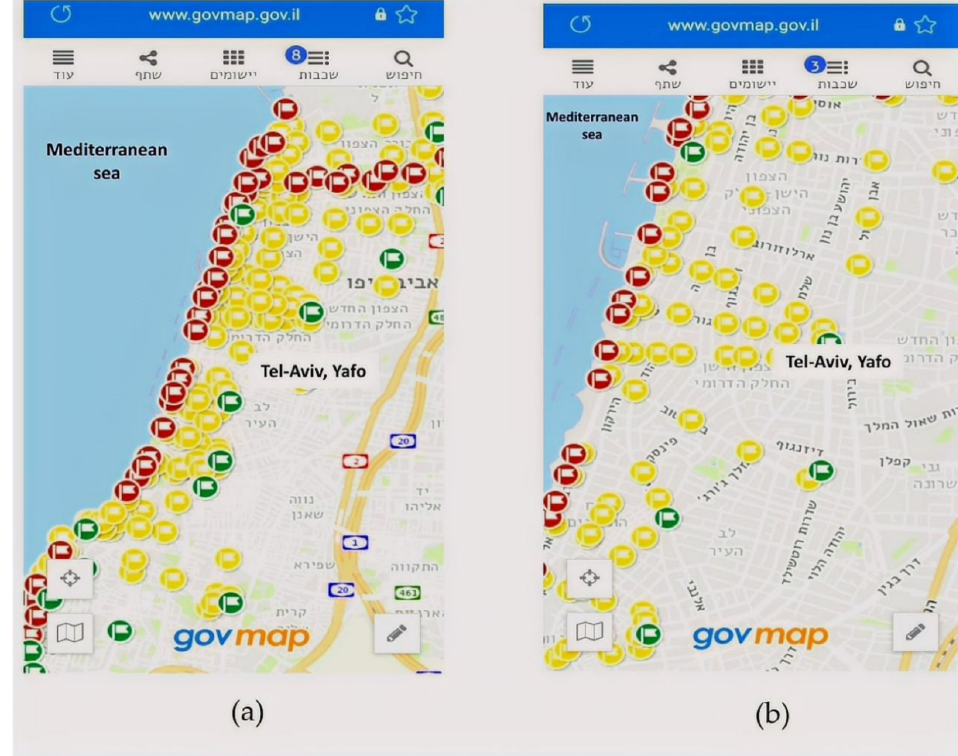
Figure 4. Tsunami signage self-evacuation map of: ( a ) greater Tel Aviv; ( b ) central Tel Aviv. Color flag symbols denote the location of the tsunami road signs as follows: red for a hazard zone, yellow for evacuation routes and green for assembly points (see also Figure 3). Background map by the Survey of Israel, https://www.govmap.gov.il (accessed on 25 January 2022); signage of self-evacuation plan by the author A. Y.; and courtesy of Dr. Orna Ido-Lichtman and Mr. Daniel Lanza, Israel’s National Steering Committee for Earthquake